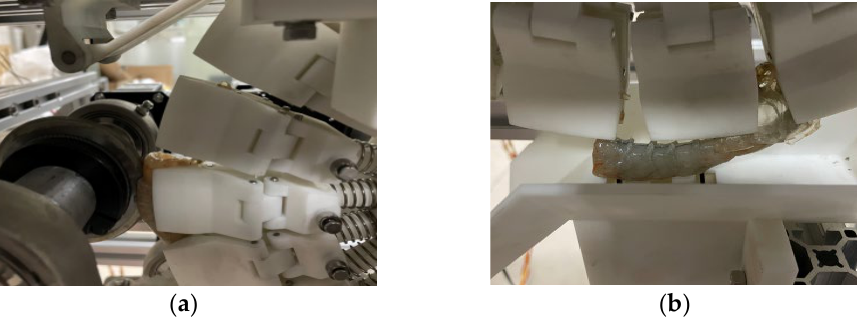
Figure 25. Performance test: ( a ) open back, and ( b ) kernel extraction.